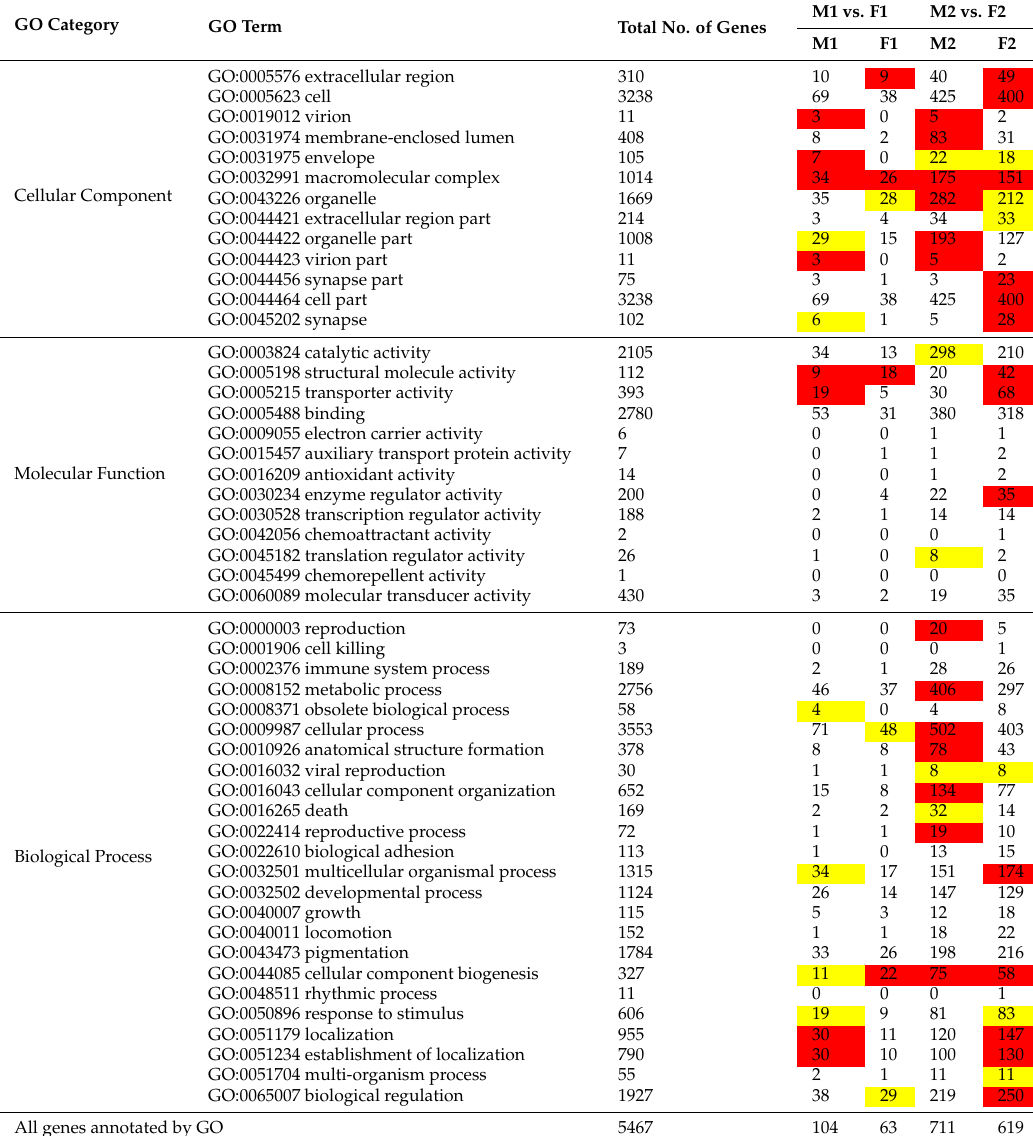
Table 1. The Gene ontology enrichment analysis of differential expressed genes. For Fisher’s exact test, p -value ≤ 0.05 is labeled as yellow, and p -value ≤ 0.01 is labeled as